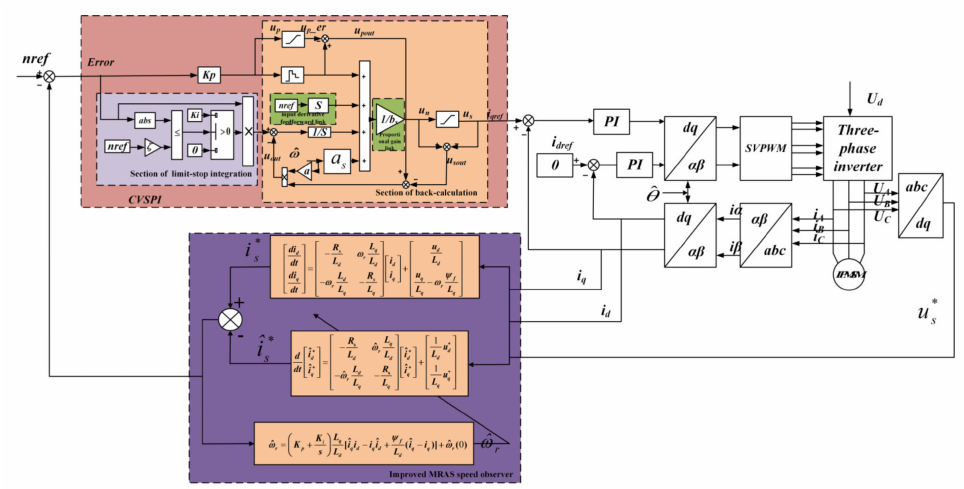
Figure 7. IPMSM speed control system without speed control.